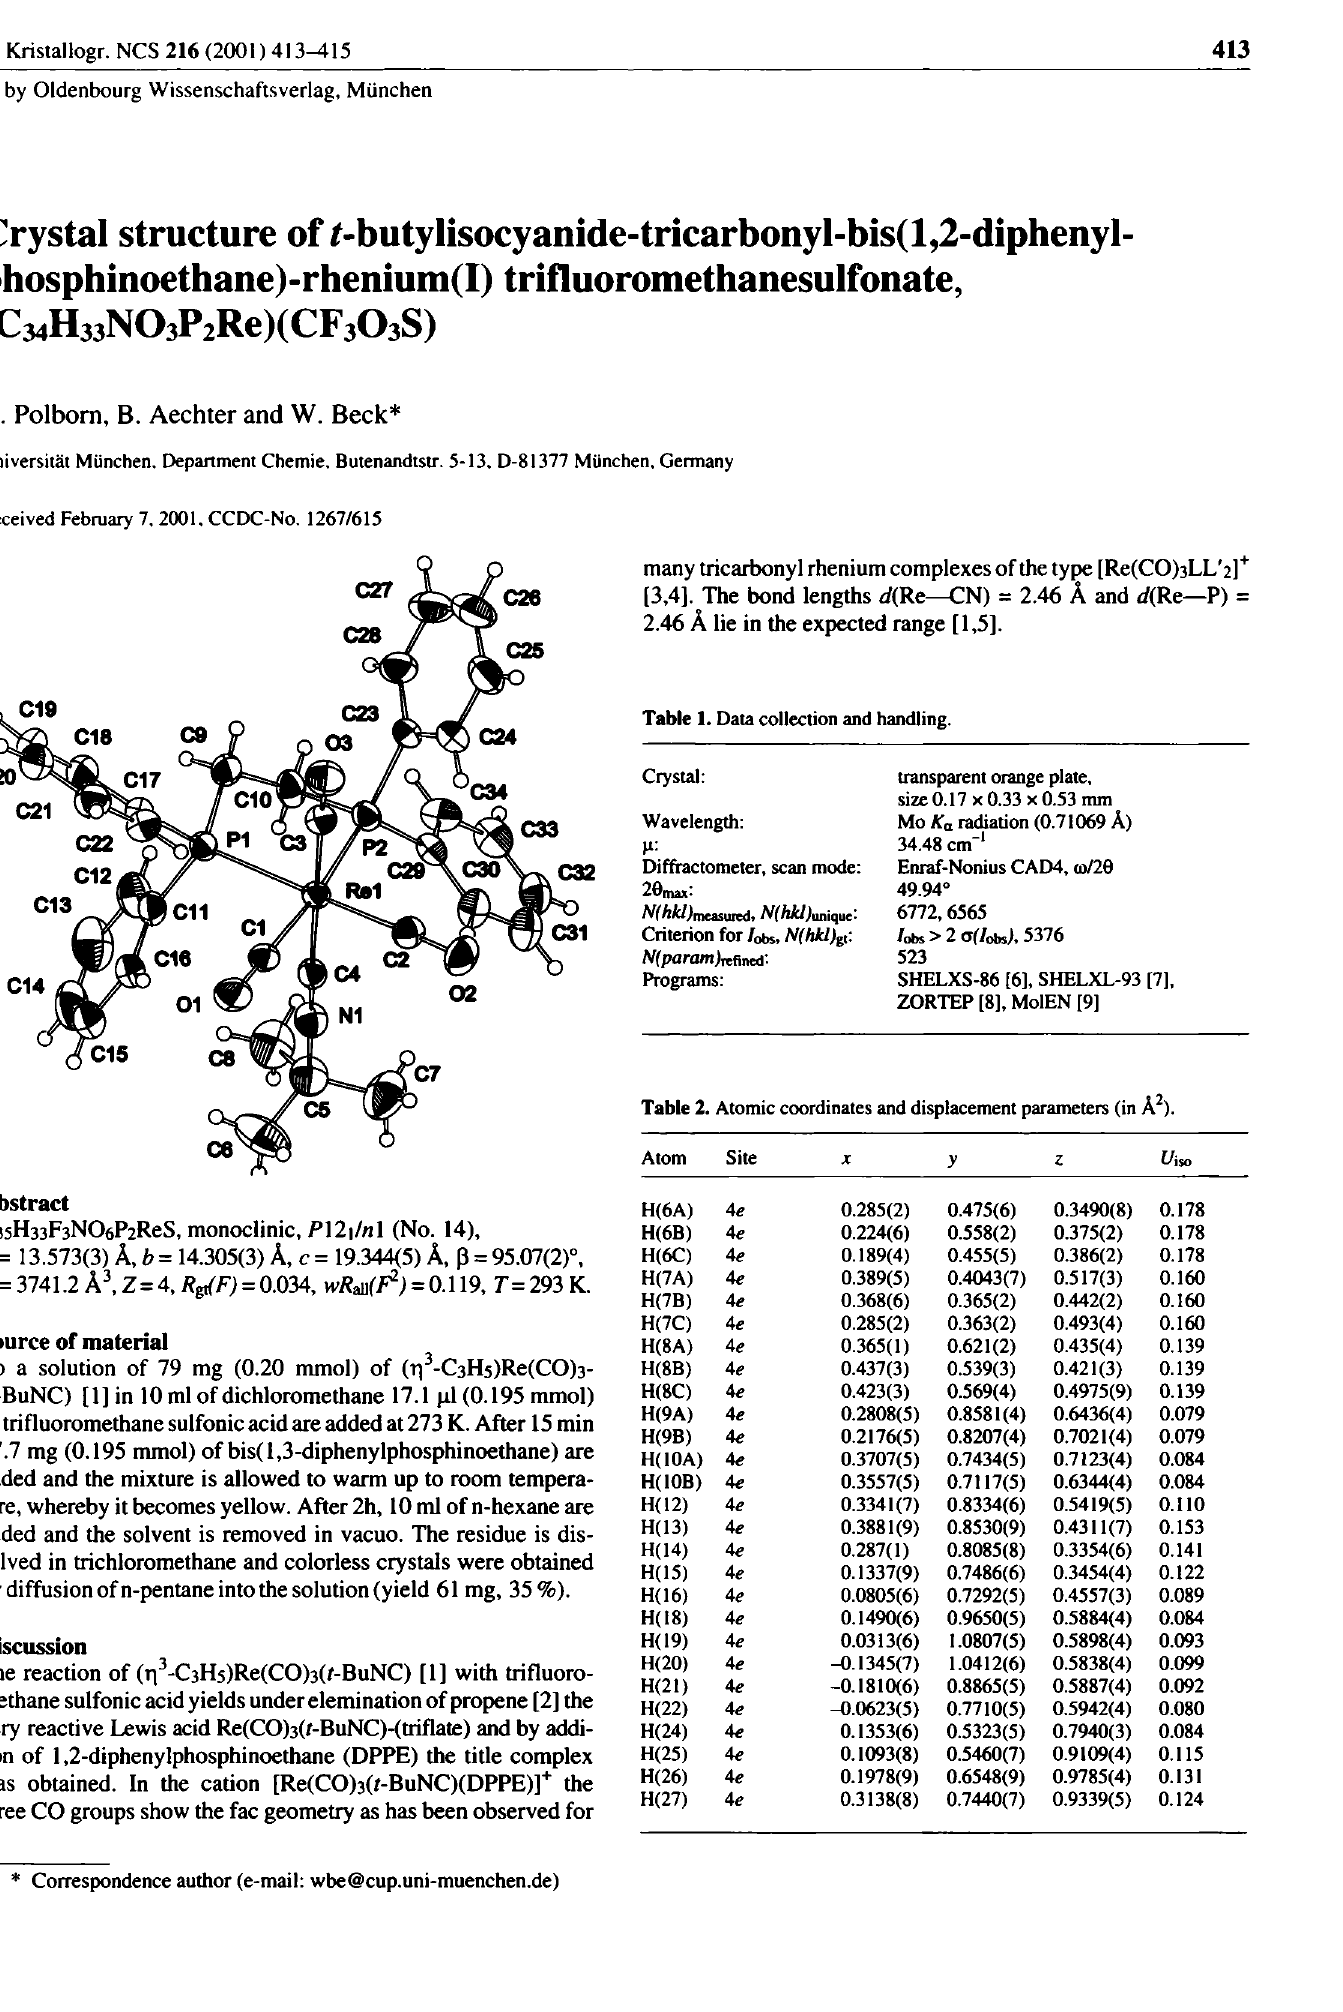
Table 2. Atomic coordinates and displacement parameters (in A 2